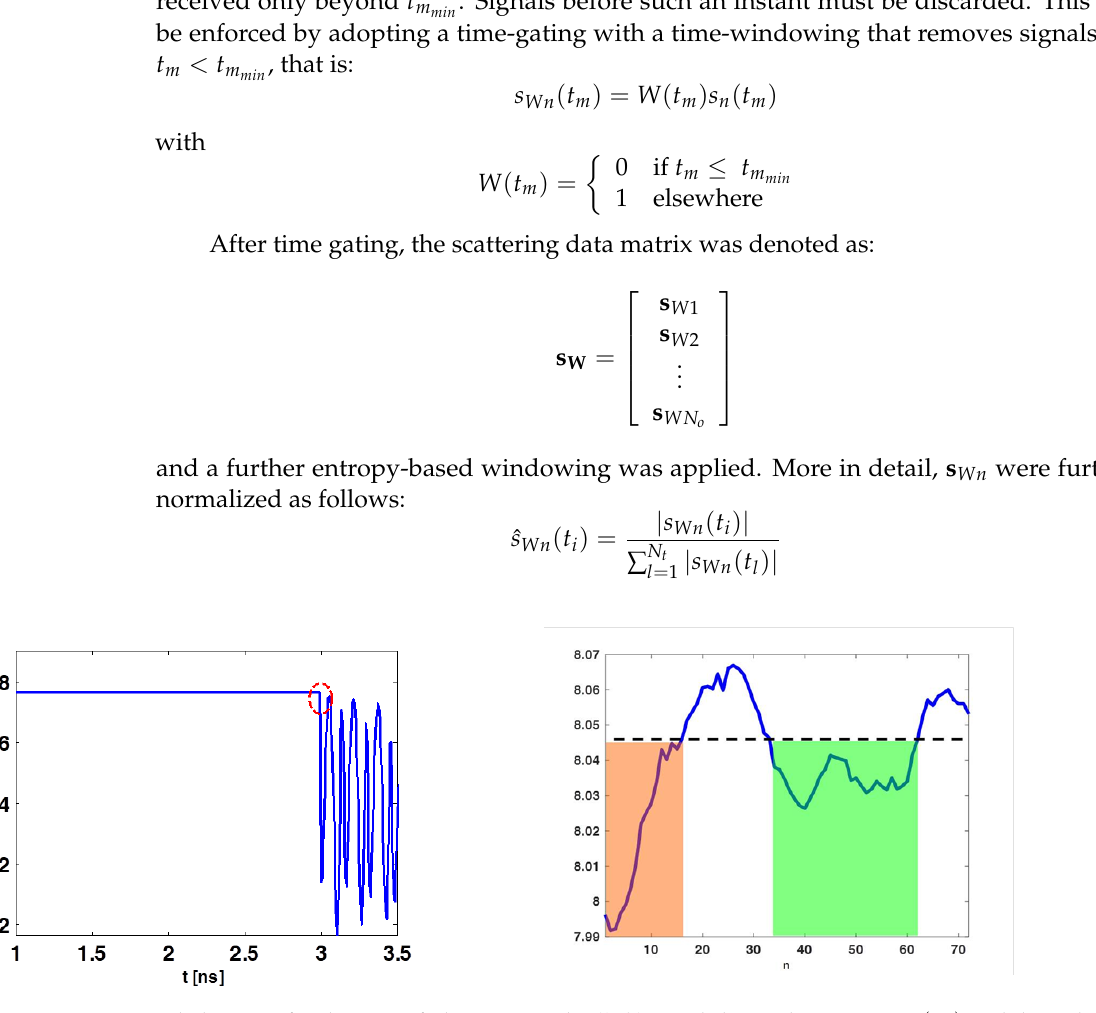
Figure 5. Illustrating entropy behaviour for the case of phantom B. The ( left ) panel shows the entropy (cid:101) s ( t m ) and the red dashed circle identifies the time-gating value (3 ns). The ( right ) panel shows ˆ (cid:101) s , the orange and green shaded regions highlights the set of sensors’ positions whose data can be